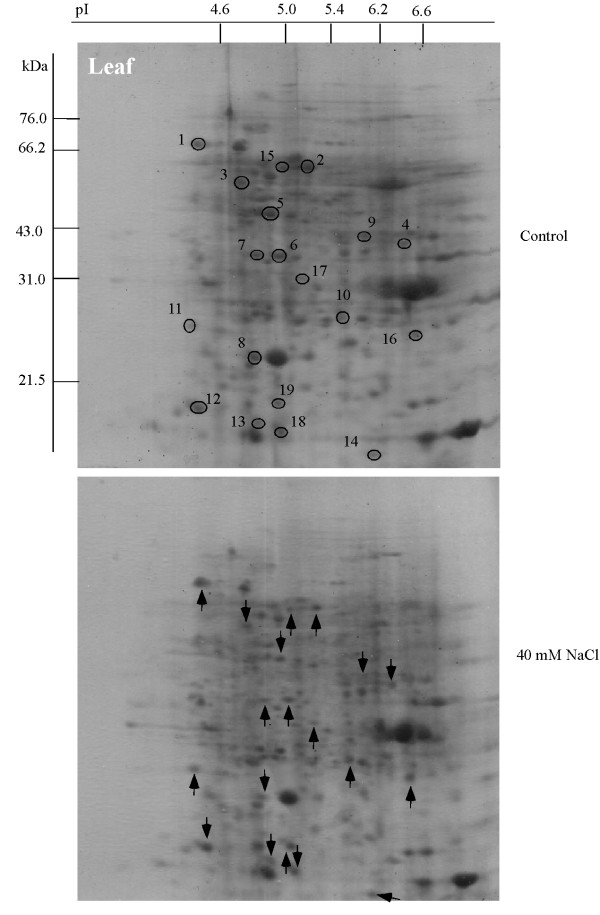
Protein expression patterns in the leaf of soybeans treated with NaCl. Seeds were sown and treated with 40 mM NaCl. After 7 days, proteins were extracted from the leaf separated by 2-DE, and visualized by CBB staining. The pI and Mr of each protein were determined using 2-DE markers (Bio-Rad). Arrows indicate protein changes due to NaCl treatment, and circles mark the position of the same proteins from the control. Upward arrows indicate up-regulation and downward arrows indicate down-regulation.